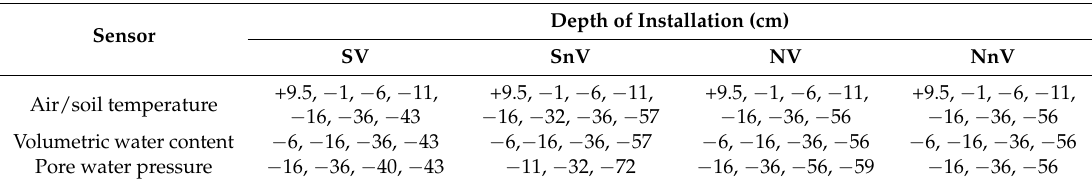
Table 2. Location of selected sensor in the four vertical profiles. Only devices focusing on temperature, volumetric water content, and pore water pressure are listed.